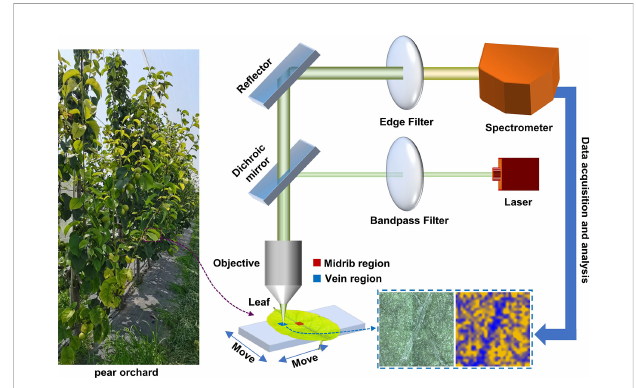
FIGURE 1 Schematic diagram of spectral-imaging measurement principles of the micro-Raman spectrometer used for pear